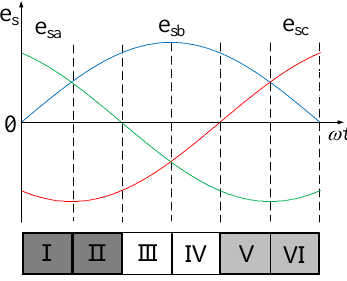
Figure 6. Six possible conduction intervals in half cycle.